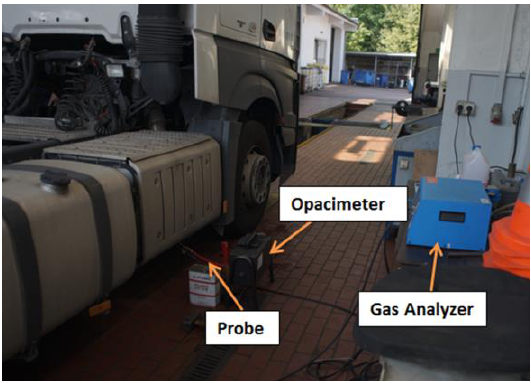
Fig. 2. A general view of the stand for measuring the composition and opacity of exhaust gases The measurements were carried out for both vehicles while the engine was idling. The limit line was considered to be the achievement of 0.2% of CO concentration, which 2 is the lower measurement threshold of the popular analyz- ers, however lower values are achievable [2]. In the case of a truck, the outlet of the exhaust pipe is located on the right side of the vehicle (Fig. 3). In the case of the coach, the exhaust gases come out from the bottom of the vehicle, in the left rear part of the body (Fig. 4). The Mercedes Actros truck is equipped with a diffuser-shaped exhaust pipe with a flattened shape and several nozzles. This results in the dispersion of the exhaust gas stream and a significant dilu- tion of the sample with the ambient air.